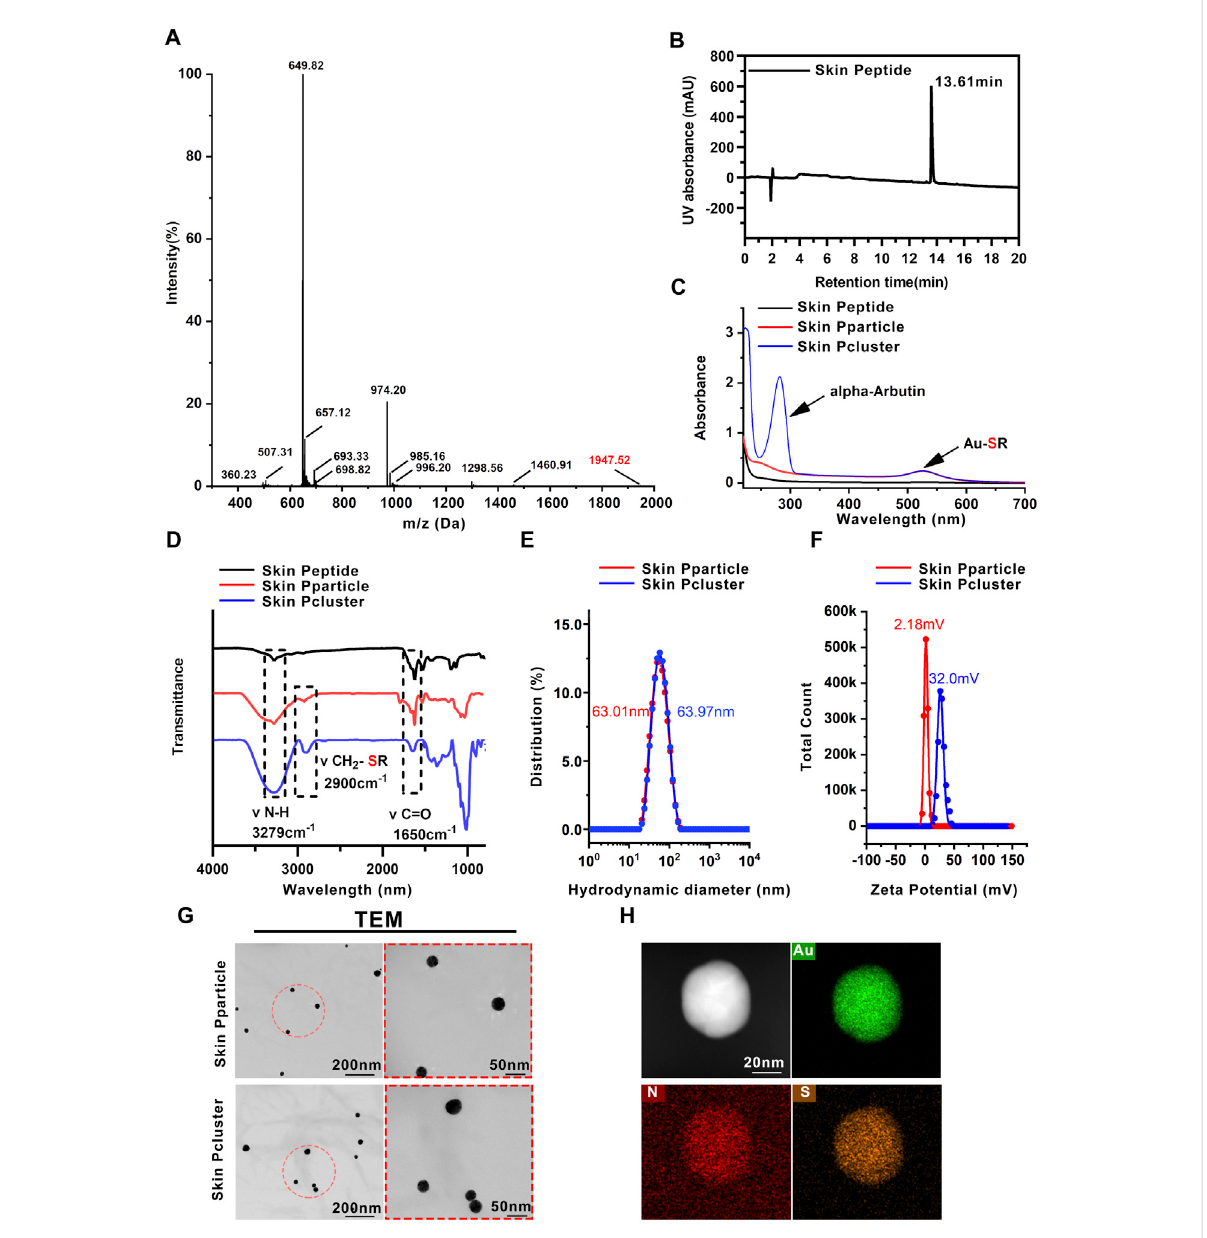
FIGURE 2 Characterization of Skin Pcluster. (A) The molecular weight of the Skin Peptide was identi fi ed by electrospray ionization mass spectrometry. (B) Retention time and purity of Skin Peptide was quantitatively analyzed by high performance liquid chromatography (HPLC) on a C18 column at 214 nm. (C) UV-vis spectra of Skin Peptide, Skin Pparticle and Skin Pcluster. The characteristic absorption peaks of Au-SR and alpha-Arbutin (aromatic compound) were visualized at 520 nm and 283nm, respectively. (D) FTIR spectra of the Skin Peptide, Skin Pparticle and Skin Pcluster weredeterminedafterlyophilization.Threeabsorptionpeaksat3279 cm − 1 ,2900 cm − 1 and1650 cm − 1 demonstratedthestretchingvibrationofN-H, CH 2 -SR, and C=O, respectively. (E) Hydrodynamic diameter distributions of the Skin Pparticle and Skin Pcluster were performed by dynamic light scattering. (F) The surface charge (Zeta potential) of the Skin Pparticle and Skin Pcluster was measured in PBS at pH7.4. (G) TEM images of the Skin Pparticle and Skin Pcluster were obtained by a CCD camera. The red circles represent magni fi cation-related regions of the Skin Pparticle and Skin Pcluster. (H) Elemental analysis of Skin Pcluster was recorded by